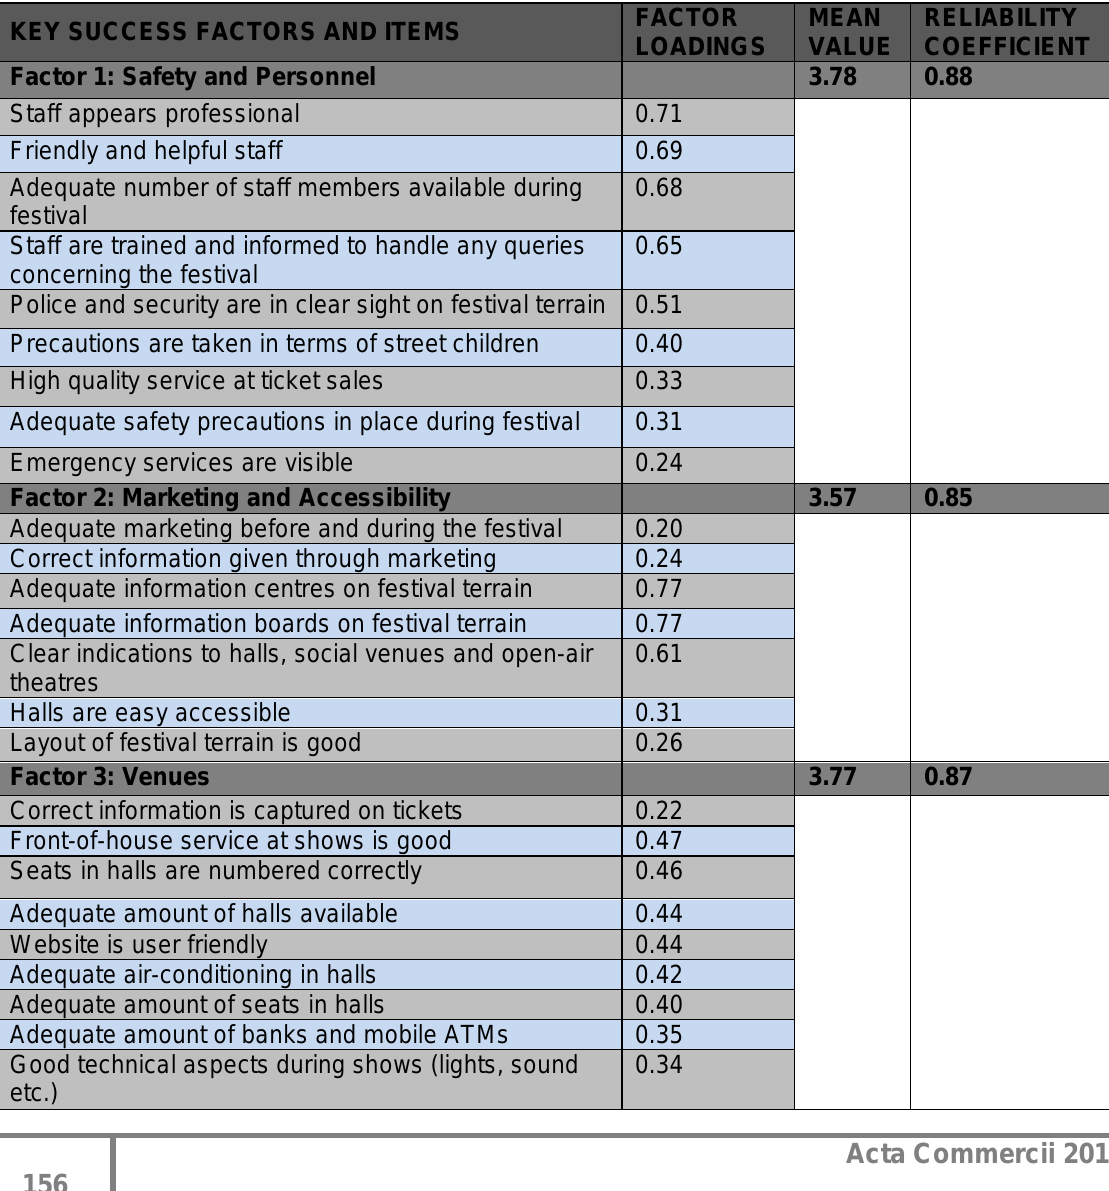
Table1: Factor analysis of the key success factors KEY SUCCESS FACTORS AND